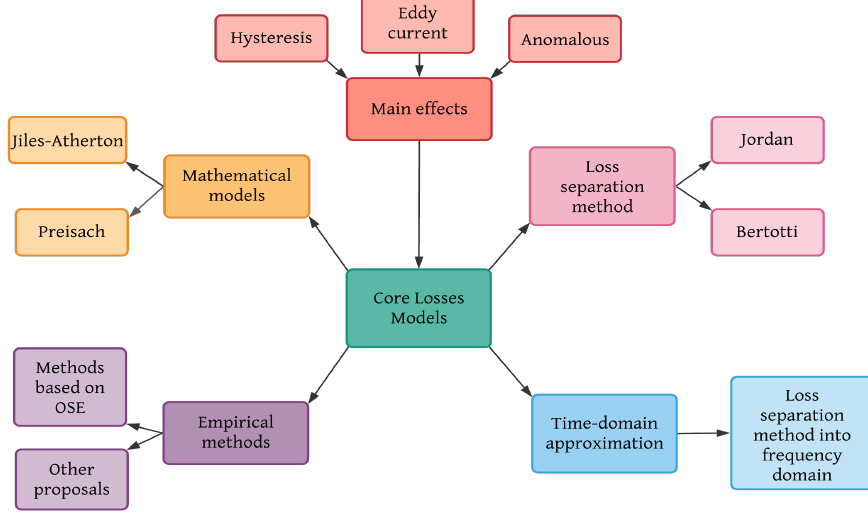
Figure 3. Classification of core losses